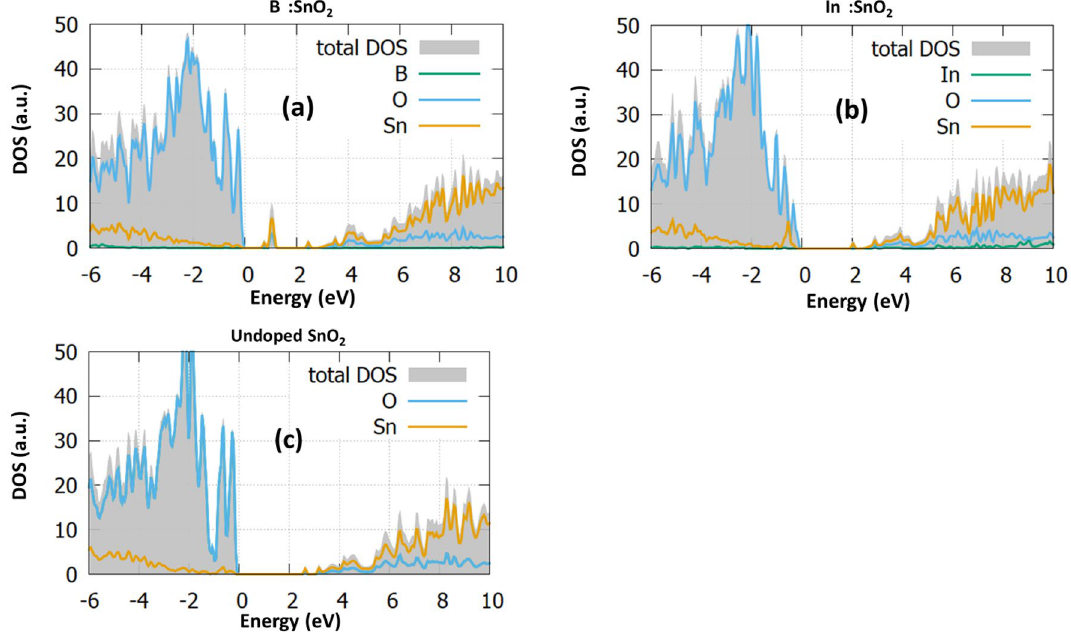
Figure 7. The total density of states (DOS) and the projected density of states (PDOS) of ( a ) B ( b ) In and ( c ) undoped (110) SnO 2